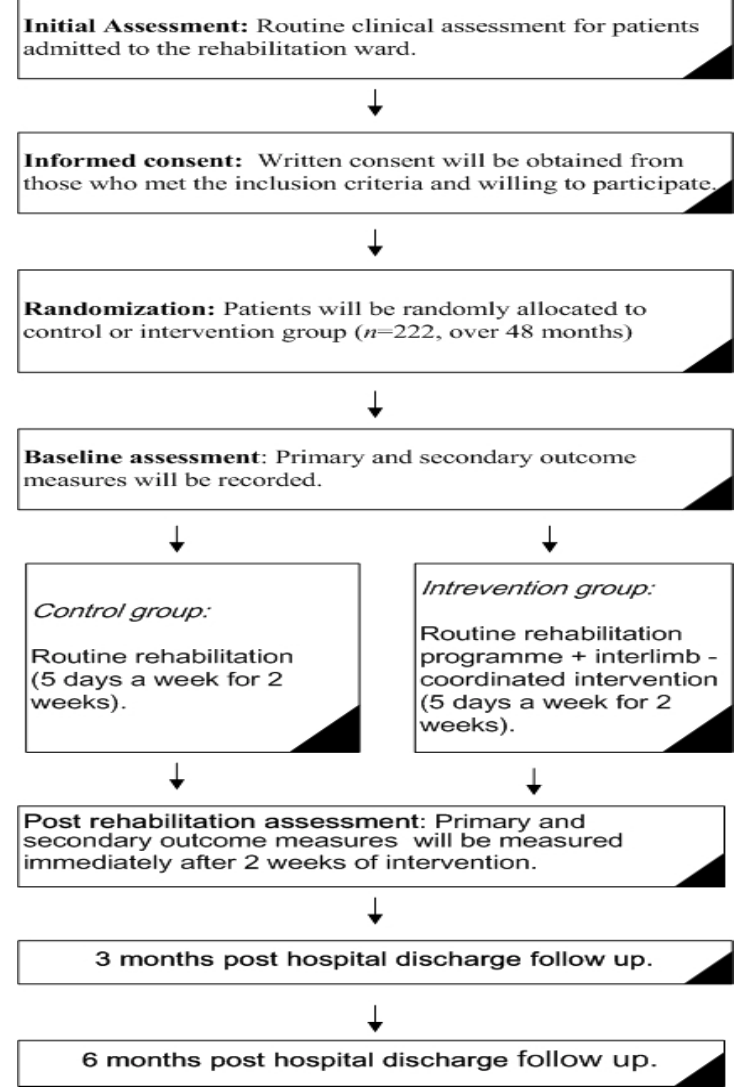
Figure 1. Flow diagram of the study procedure.